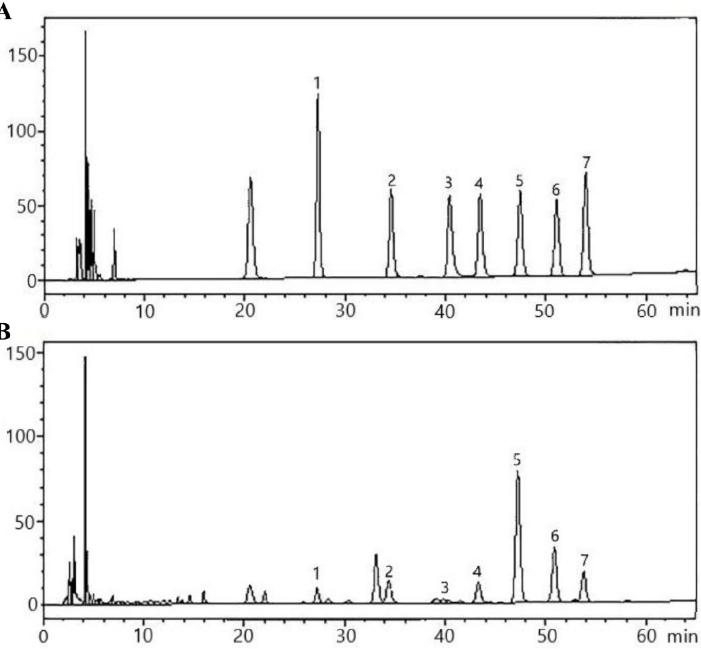
Figure 2. HPLC profile of monosaccharide, alduronic acid mixed standard ( A ) and polysaccharide samples ( B ). 1. Mannose, 2. rhamnose, 3. glucuronic acid, 4. galacturonic acid, 5. glucose, 6. galactose, 7. arabinose.